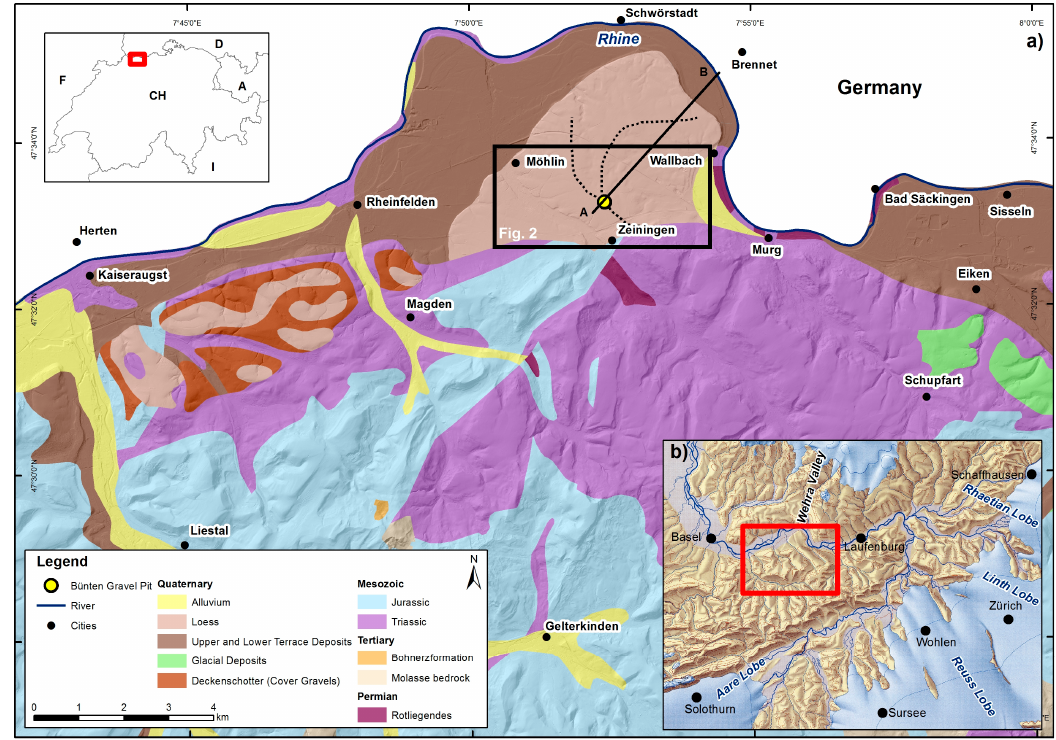
Figure 1. ( a ) Simplified geological map of the Möhlin area. The black dotted lines indicate the ridges that have been interpreted as moraines by Penck and Brückner [9]. The black rectangle indicates the extent of Figure 2. The cross-section A–B is given in Figure 3. ( b ) Extent of the Aare, Reuss, Linth, and the Rhaetian Lobes in the Swiss northern Alpine Foreland during the Last Glacial Maximum (LGM) [20]. The background map and the geological 1:500,000 map are reproduced with the authorization of the Swiss Federal Office of Topography (swisstopo).